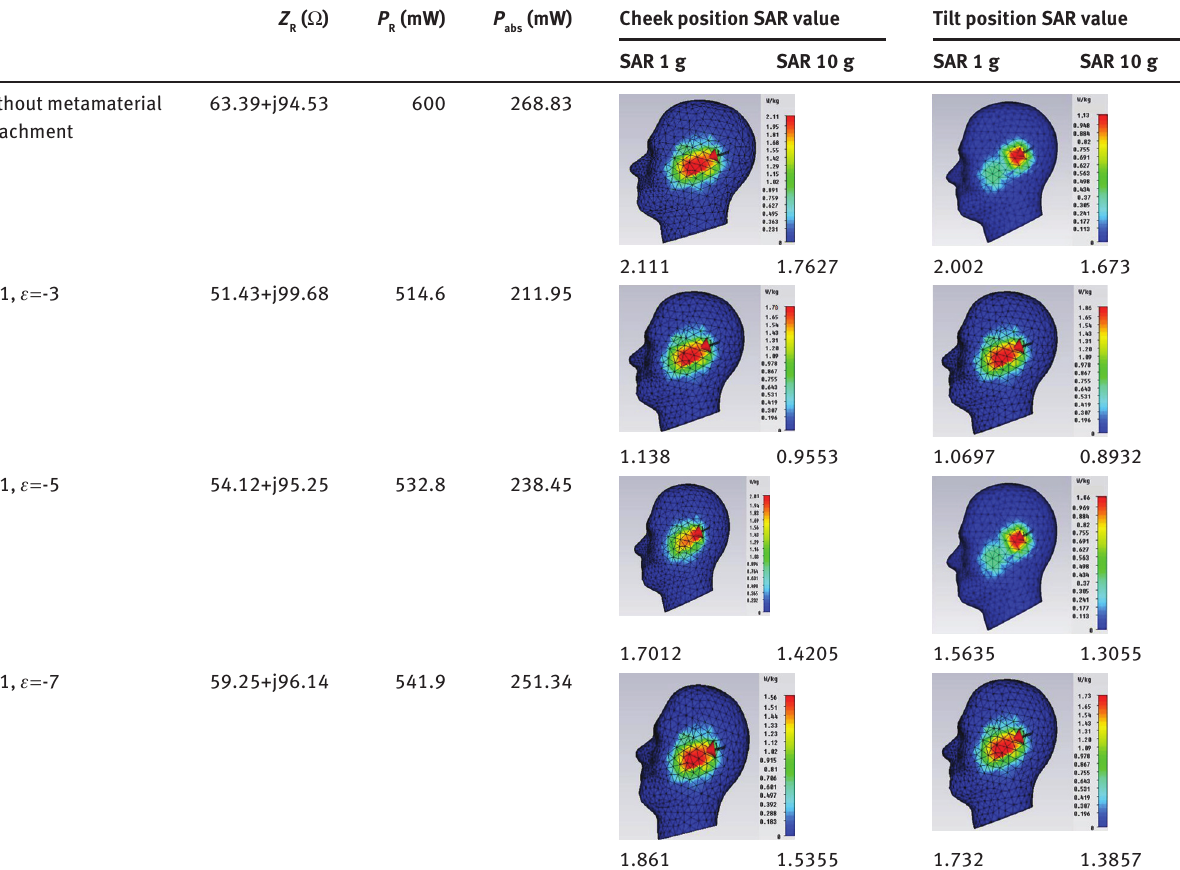
Table 1 Effects of SMMs on antenna performance and SAR reduction at 900